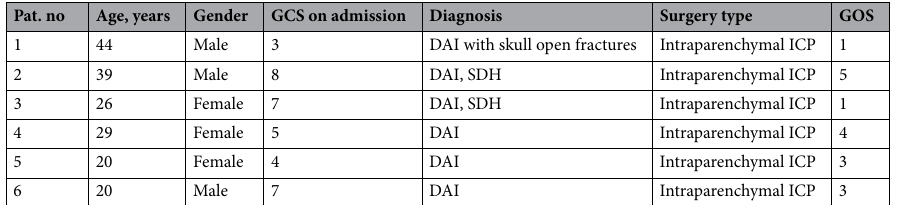
Table 1. Demographic data and clinical conditions of the patients included in this pilot study. GCS Glasgow coma scale, GOS Glasgow outcome scale, DAI diffuse axonal injury, SDH subdural hematoma, ICP intracranial pressure.